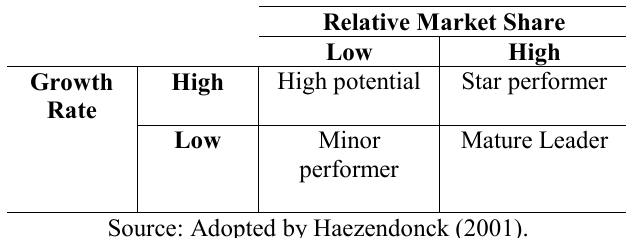
Figure 5: The BCG matrix applied to seaport